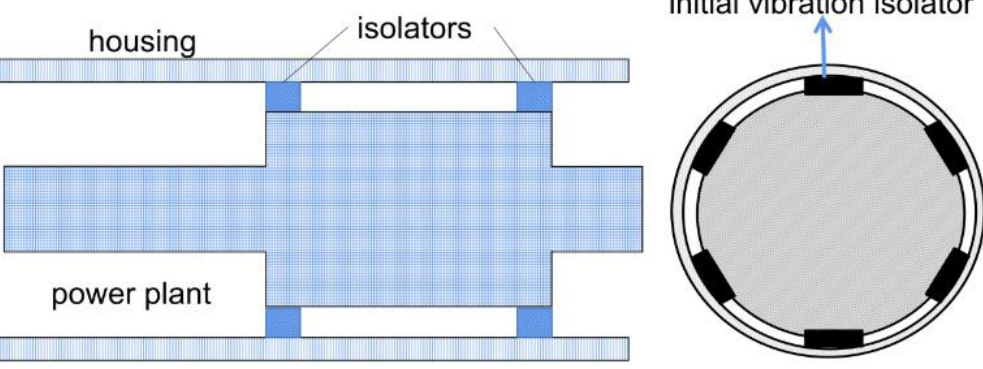
Figure 1. Schematic diagram of the dynamic vibration isolation device.